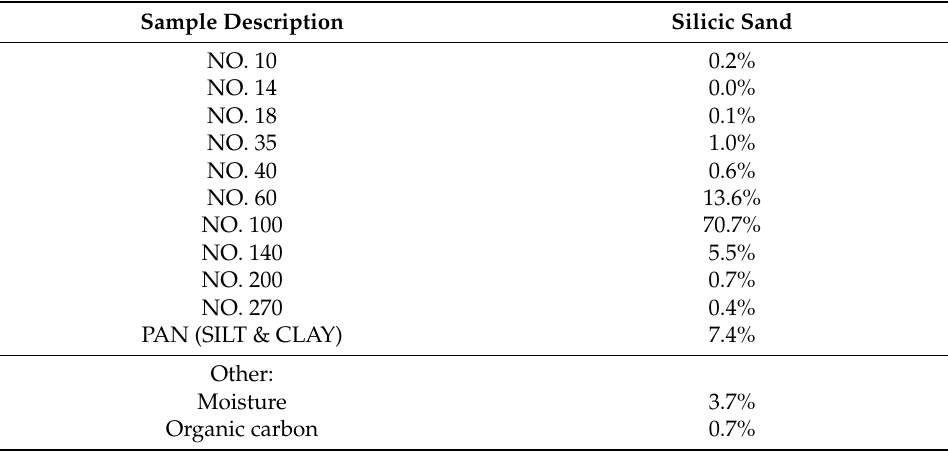
Table A4. Particle size distribution